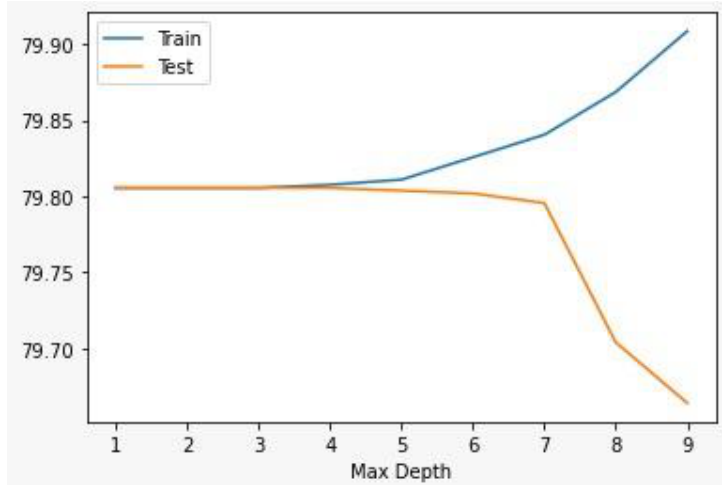
Figure 3. Performance comparison of the decision tree algorithm based on the maximum depth hyperparameter of the